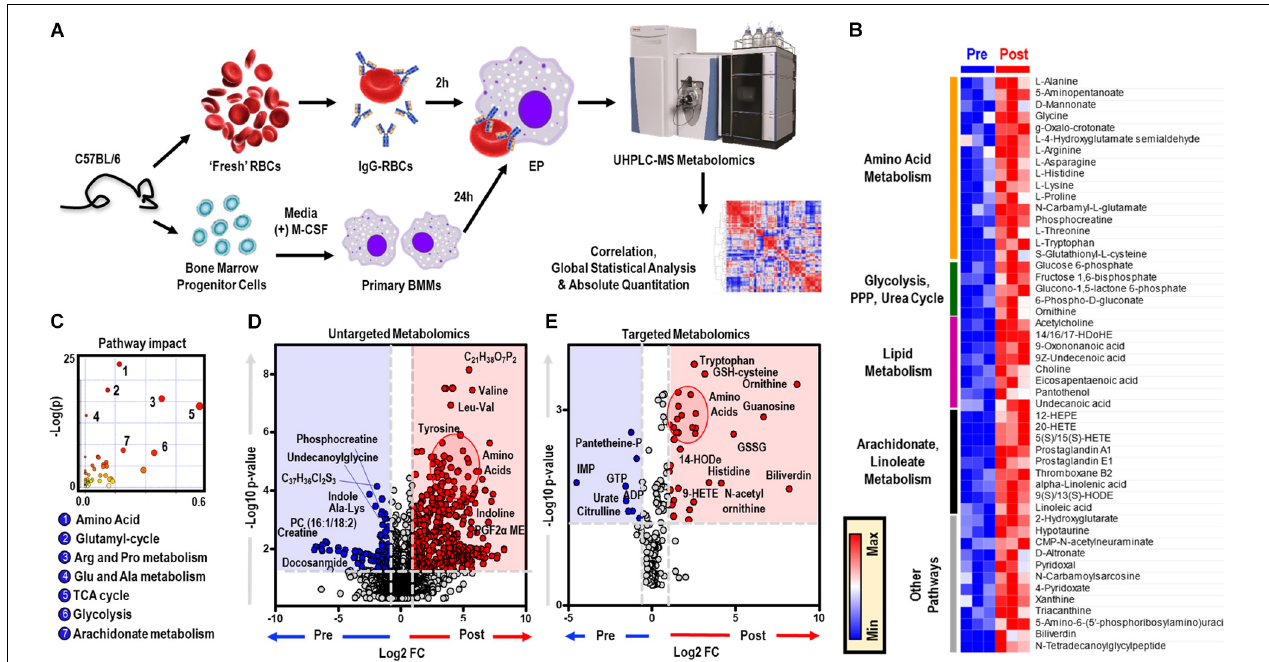
FIGURE 1 | In vitro assessment of BMDM EP. Mouse RBCs were incubated with rabbit, anti-mouse RBC IgG. BMDMs were then incubated with PBS (control) or with IgG-coated RBCs for in vitro opsonization to reflect EP. (A) Metabolic correlates identified before (Pre) and after (Post) EP were plotted as a hierarchically-clustered heat map (B) . The metabolome view map of relevant metabolic pathways showed significant changes in cellular metabolic pathways following EP (C) . Univariate analysis of the BMDM metabolome using untargeted (D) and targeted (E) metabolomics methods to identify metabolites that change due to EP. The region highlighted in red (fold change (FC) ≥ 2.0; p -value < 0.05) indicates metabolites that are present in significantly higher amounts in BMDMs following EP (Post); whereas, the region highlighted in blue (fold change ≤ 0.5; p -value < 0.05) indicates metabolites that accumulate in BMDMs before EP (Pre). Amino acids identified clustered in similar regions of Pre were encircled ( red